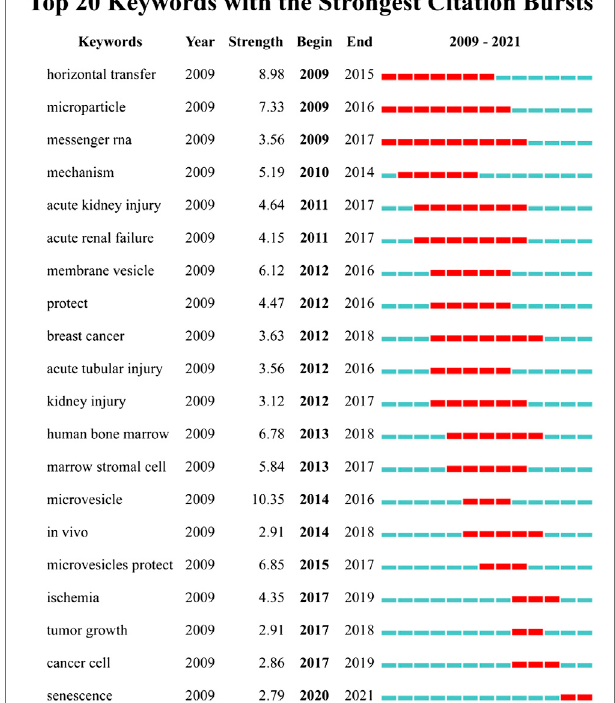
FIGURE 8 | Top 20 keywords with the strongest citation bursts based on CiteSpace.